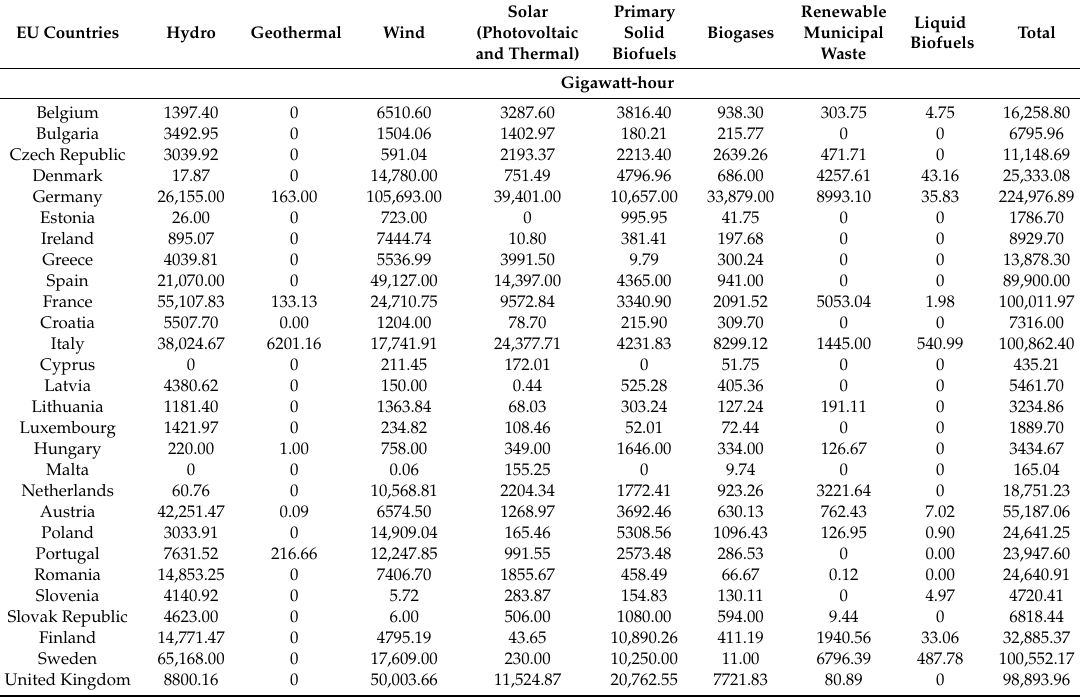
Table 1. Structure of energy production from renewable energy sources in the EU countries in 2017 (own study based on data from [37]). EU